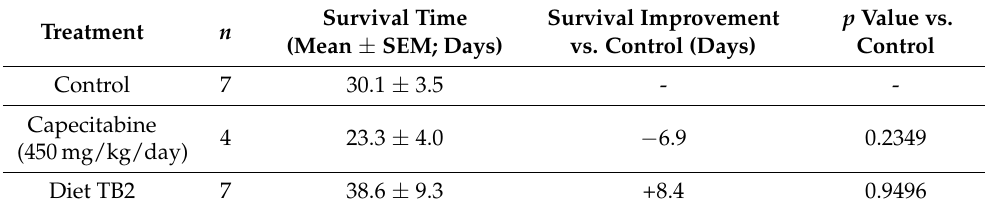
Table 4. Survival of mice with breast cancer treated with diet TB2 or capecitabine.